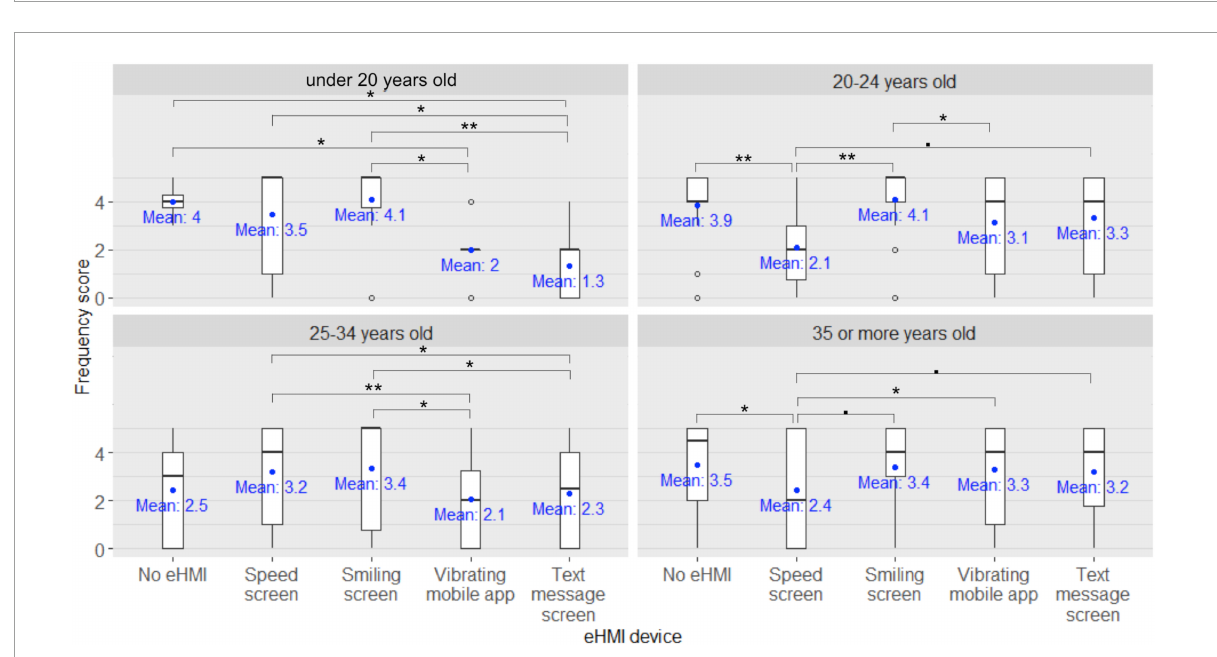
screen compared to the text message screen ( pFDR = 0.06). Among the 25–34 year-old kick scooter users, participants’ frequency scores were lower when they were equipped with